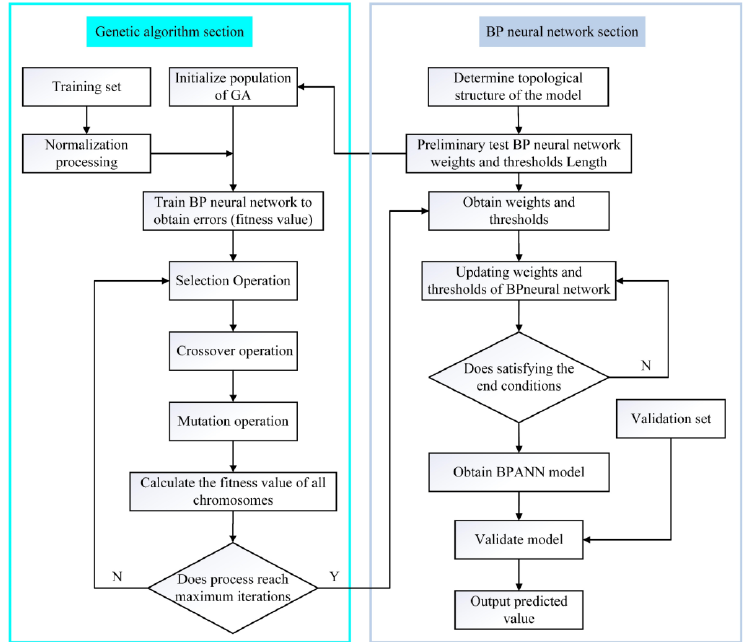
Figure 11. Flowchart of GA/BP-ANN.